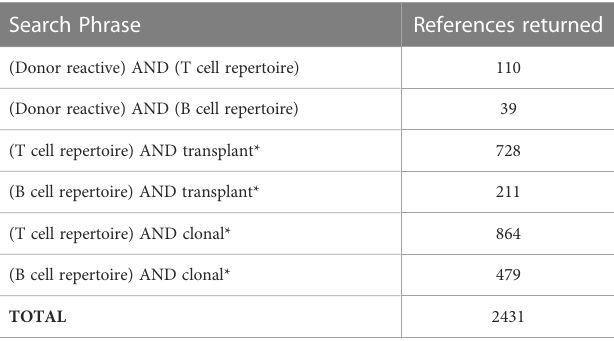
TABLE 1 Selected search phrases submitted to PubMed on Oct 27,